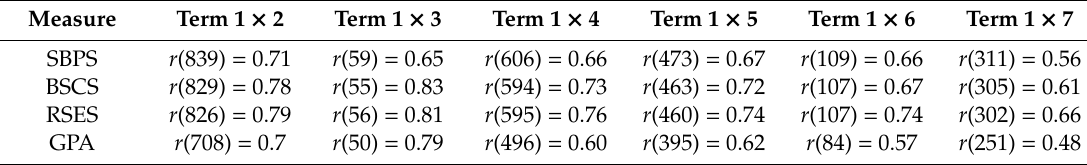
Table 3. Longitudinal Consistency across Measures 1